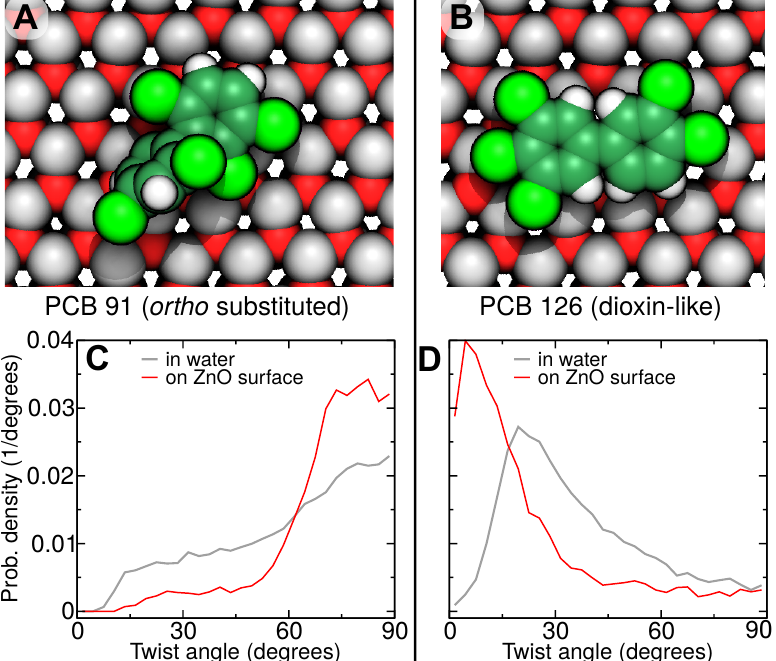
Figure 6. Twist angle distributions of two pentachlorobiphenyls, PCB 91 (tri- ortho -substituted) and PCB 126 (no ortho substitutions, dioxin-like). Simulation snapshot of PCB 91 ( A ) and PCB 126 ( B ) adsorbed to the model ZnO surface. For clarity, water molecules are not shown. Distribution of the angle between the two phenyl groups for PCB 91 ( C ) and PCB 126 ( D ). The distributions are derived from simulations with each PCB in pure water or adsorbed to the model ZnO